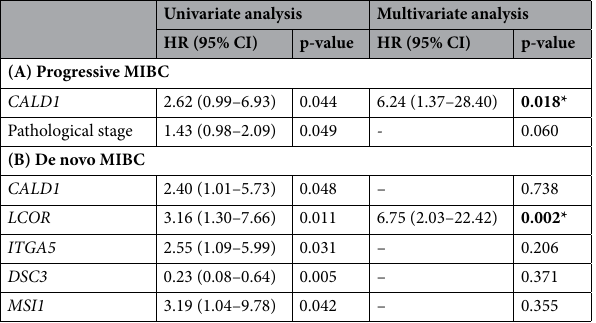
Table 4. Cancer-specific survival in progressive and de novo MIBC patients. HR Hazard ratio, CI confidence interval. *Statistically significant values are in